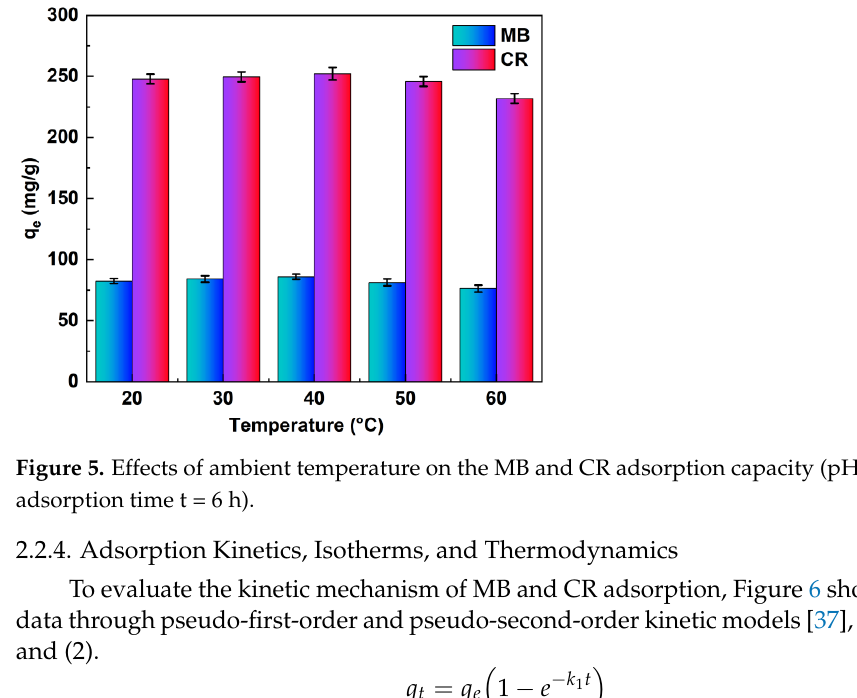
Figure 4. Effects of the adsorption time on the MB and CR adsorption capacity (pH value pH = 7, a mbient temperature T = 20 °C).